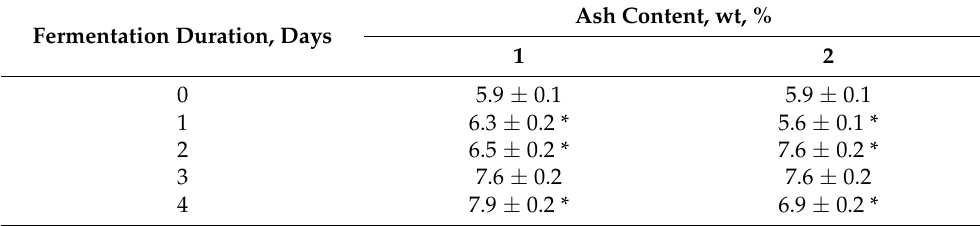
Table 3. Results of quantitative determination of ash content in samples at different fermentation